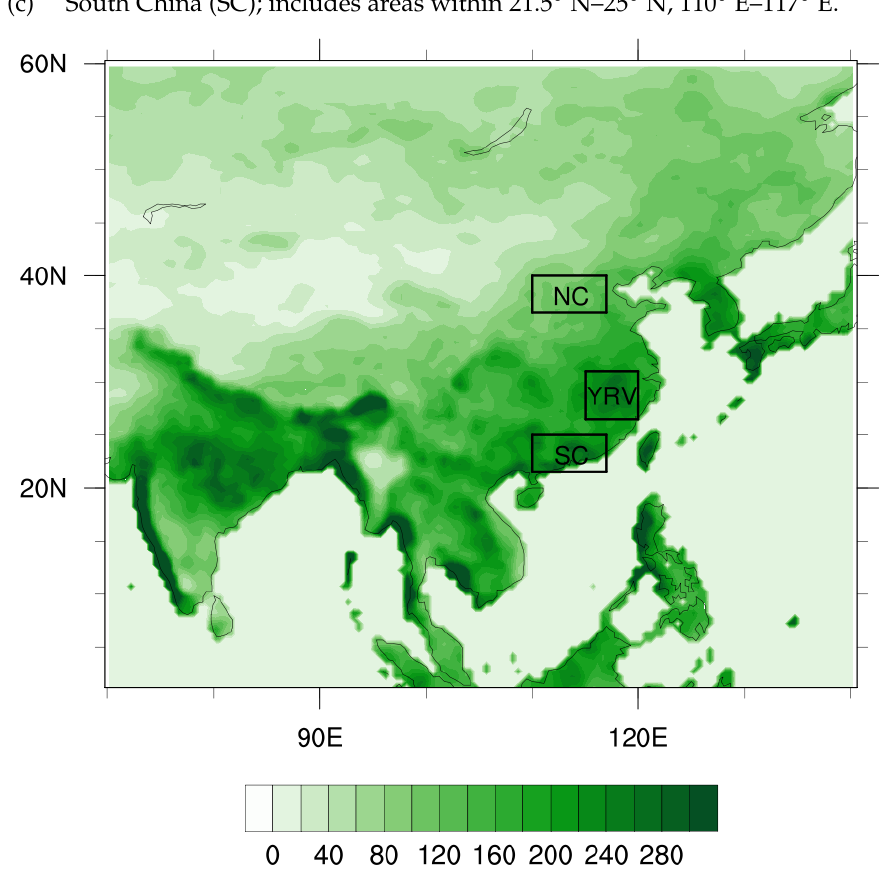
Figure 1. The 95th percentile (mm) of the distribution for 14-day precipitation totals from 1980 to 2019. The three regions (a) North China (NC), (b) Yangtze River Valley (YRV) and (c) South China (SC) of study for the Eastern China are delineated by the black-outlined polygons.